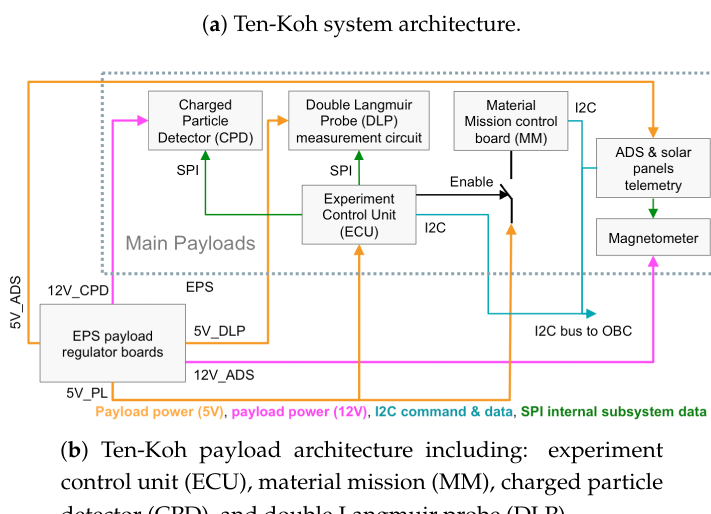
Figure 2. Block diagrams of the Ten-Koh system as well as its payloads. Dashed lines show the limit of each subsystem and the solid lines indicate the type of interface. Ten-Koh satellite uses I2C as the main data bus (blue), and SPI (gray) as a backup data bus and direct interface with sensors inside every subsystem. The 5 V power lines are shown in yellow and the 12 V lines in magenta. The ADS subsystem was included inside the payload subsystems (PL) for convenience in the physical location inside the satellite, hence it appears in the bottom block